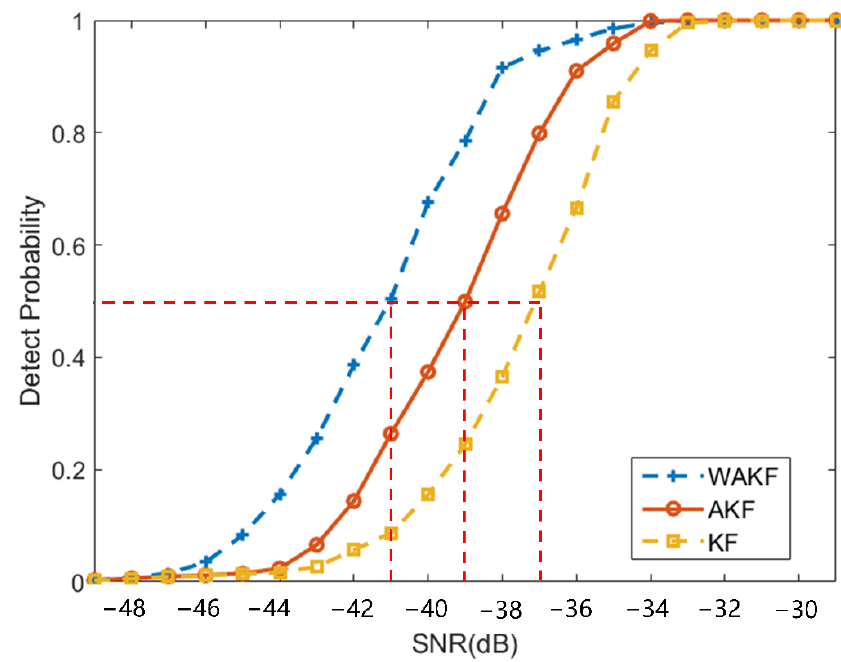
Figure 6. Frequency estimation errors of three algorithms under different SNRs.